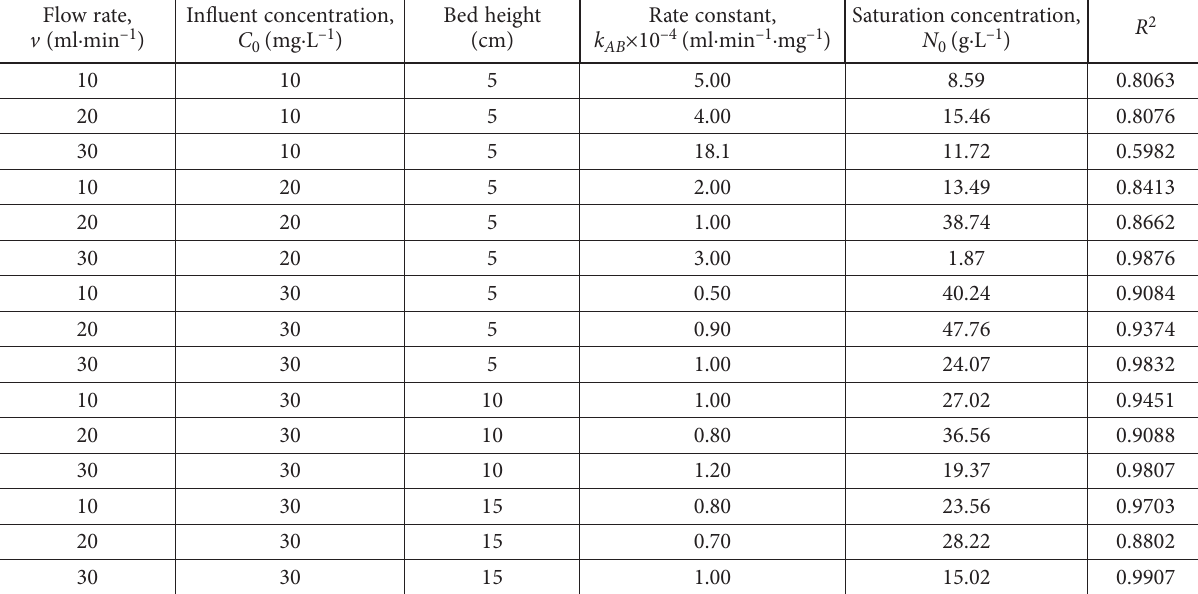
Table 1. Bohart-Adams model parameters using linear regression